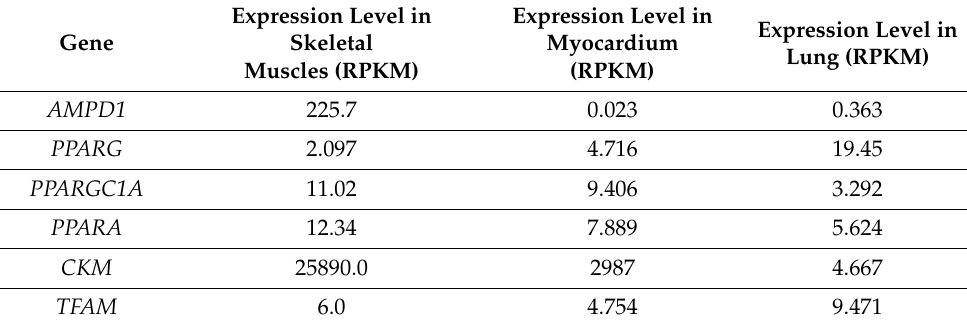
Table 3. Genes responsible for energy metabolism and their expression in skeletal muscle, my- ocardium and lungs (adapted from